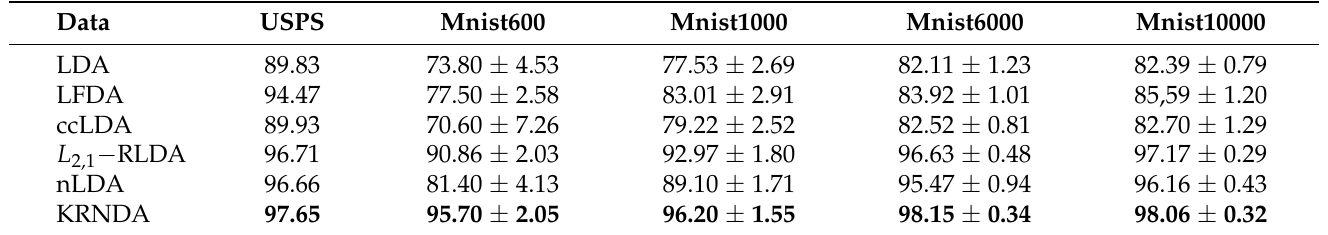
Table 4. The accuracy (%) comparison of USPS and Mnist digit recognition problems.